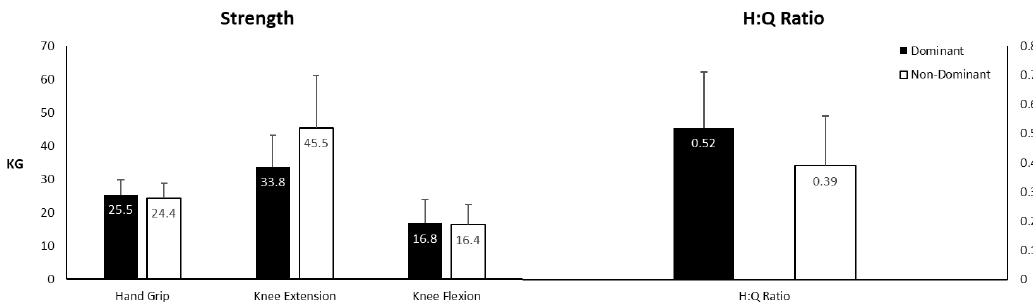
Figure 2. Means ± SD for strength values and hamstrings-to-quadriceps (H:Q) ratios of dominant and non-dominant limbs.